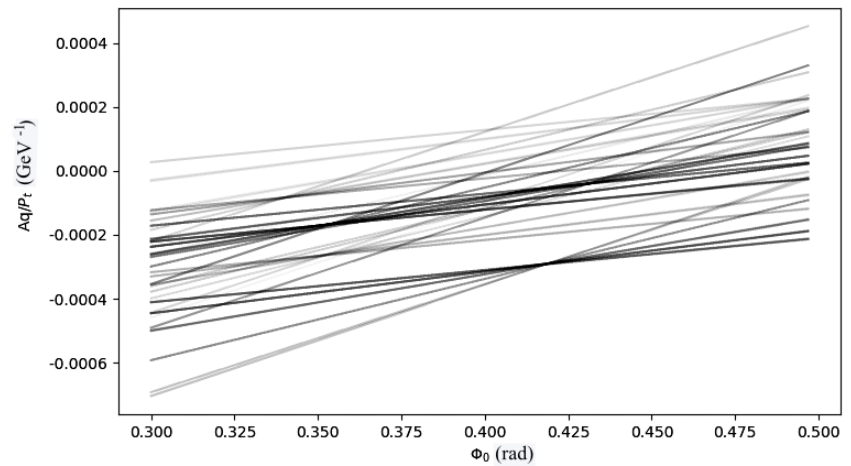
Figure 2. Hough space example (electron-Volt eV and charge (q) set to 1